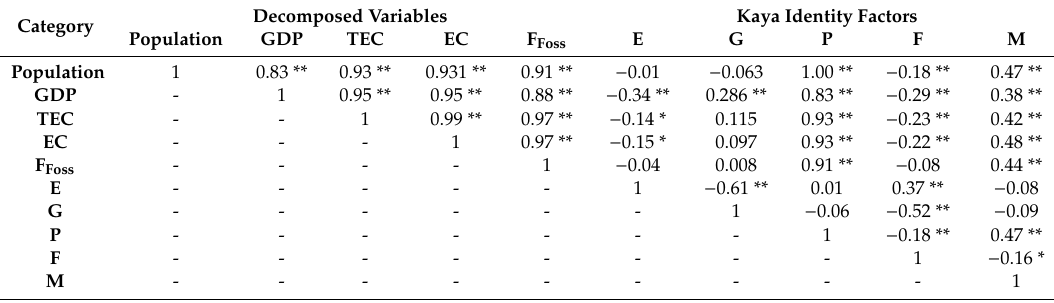
Table 4. Correlation between Kaya identity factors and their decomposed